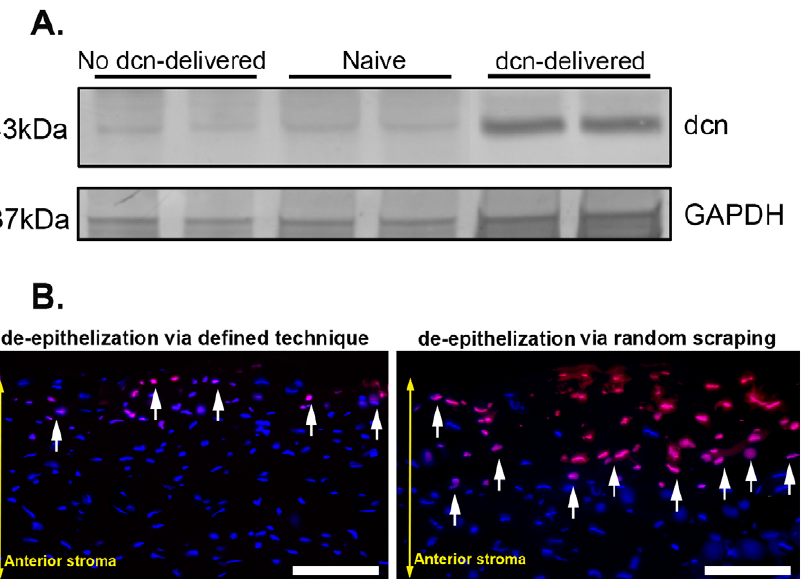
Figure 1. Representative immunoblot (A) and TUNEL assay (B) of rabbit corneas receiving AAV5-decorin or AAV5-gfp. Representative western blotting showing AAV5-controlled decorin delivery in rabbit corneas collected 14 days after VEGF-implantation (A) and TUNEL assay detecting keratocyte apoptosis in rabbit corneas collected 4 hours after epithelial removal by two different ways (B). A strong band in AAV5-dcn treated rabbit corneas of day-14 time point reveals significant decorin delivery (8.7-fold, p , 0.05) in the stroma, and a weak decorin band in naive or AAV5-gfp treated corneas indicates low endogenous decorin expression (A). GAPDH was used to confirm equal protein loading in each well and normalization of the data. TUNEL-stained rabbit corneal sections of 4-hour time point shown in Panel B demonstrate minimal keratocyte apoptosis (arrow) in cornea deepithelialized via gentle scrapping with # 64 surgical blade by running blade at 45 u angle (left panel) compared to high keratocyte death in cornea in which epithelium was removed in random manner with # 64 surgical blade (right panel). Scale bar denotes 100 m m. dcn=decorin.